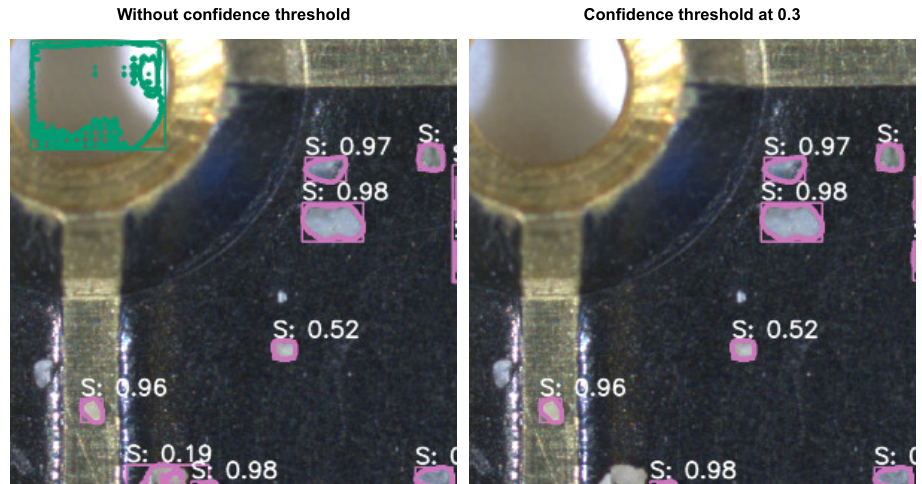
Figure A2. Examples of predicted bounding boxes and segmentation masks for the “sediment” class. ( Left column ): Overlapping predictions can be seen near the middle of both images. In addition, notice that several objects have been missed entirely. ( Right column ): Most of the overlapping predictions have been removed by thresholding the confidence score at